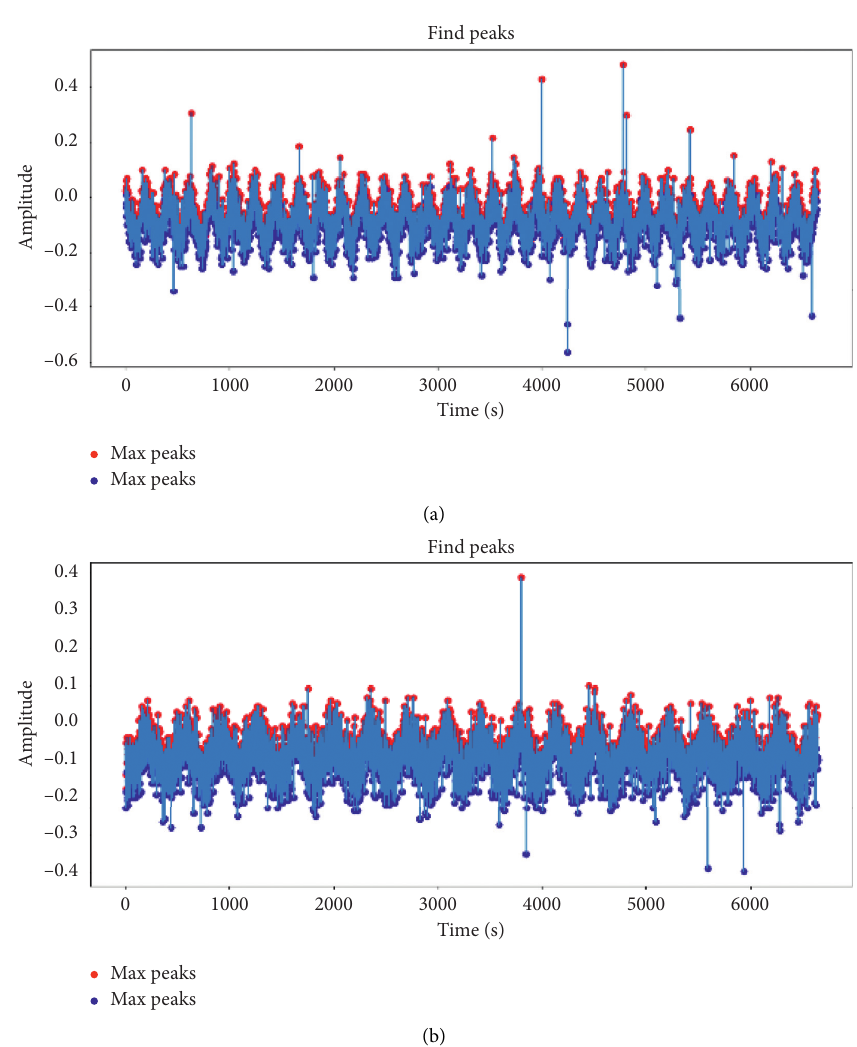
Figure 11: Vibration signal and envelope